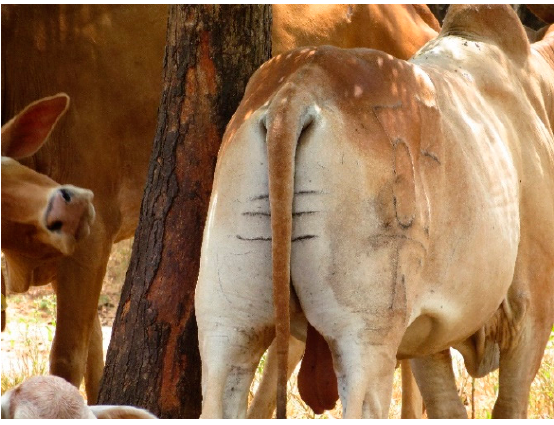
Figure 6. Branding is practiced in traditional veterinary medicine. Here, the three lines branded along either side of the tail are meant to guard against disease.